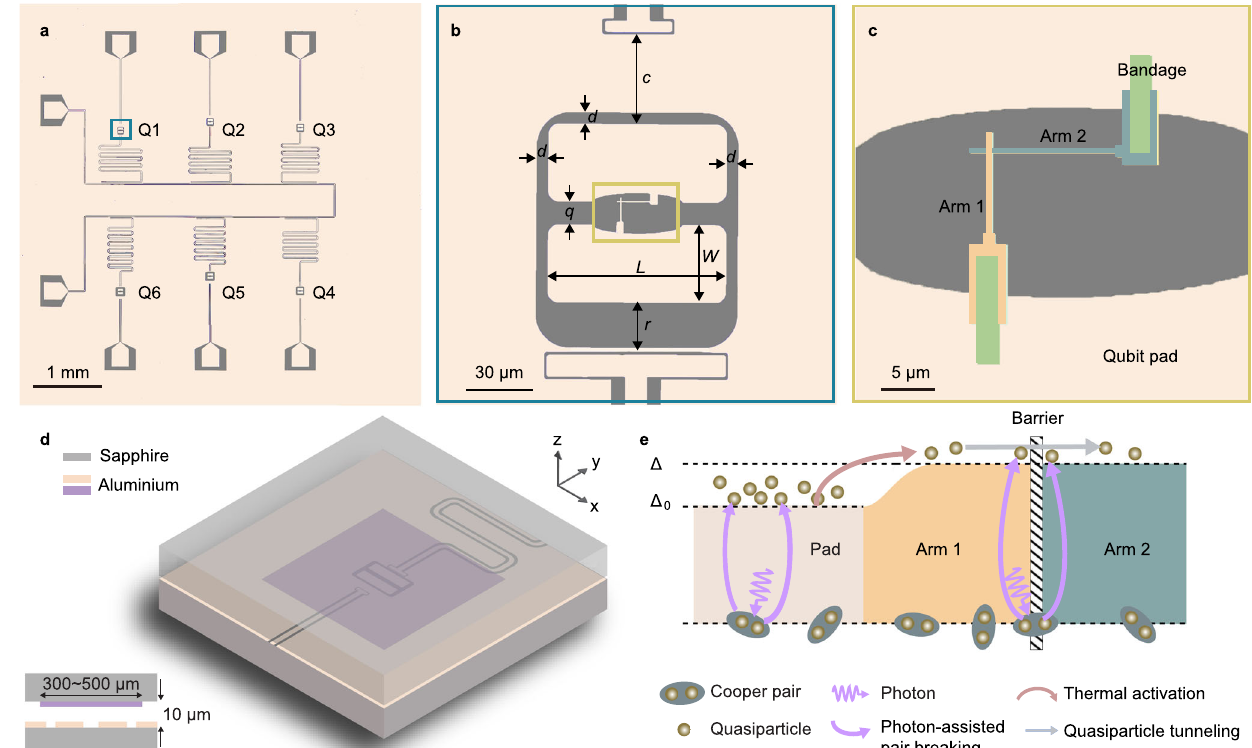
Fig. 1 | Device layout and photon-assisted quasiparticle generation. a Optical micrograph of a planar-design 6mm×6mm sample chip. The light area indicates the base aluminium layer; the dark area indicates the exposed sapphire substrate. Each qubit (Q1--Q6) has a dedicated charge drive line (straight transmission line) and a dedicated readout resonator (meandering transmission line). The six reso- nators share a common feed line for a multiplexed readout. b Close-up view of Q1 (blue rectangle in a ), showing two aluminium pads (length L and width W ) fl oating inside an aperture. The pad-to-resonator distance is r ; the pad-to-ground distance on the other three sides is d ; the pad-to-drive-line distance is c ; the pad-to-pad distance is q . In the shown case, L =80 μ m, W =35 μ m, r =23 μ m, d =5 μ m, c =41 μ m, q =10 μ m. The qubits shown in a have varying pad-to-ground distances ( d =5 − 30 μ m). c Close-up view of the junction area (yellow rectangle in b ).